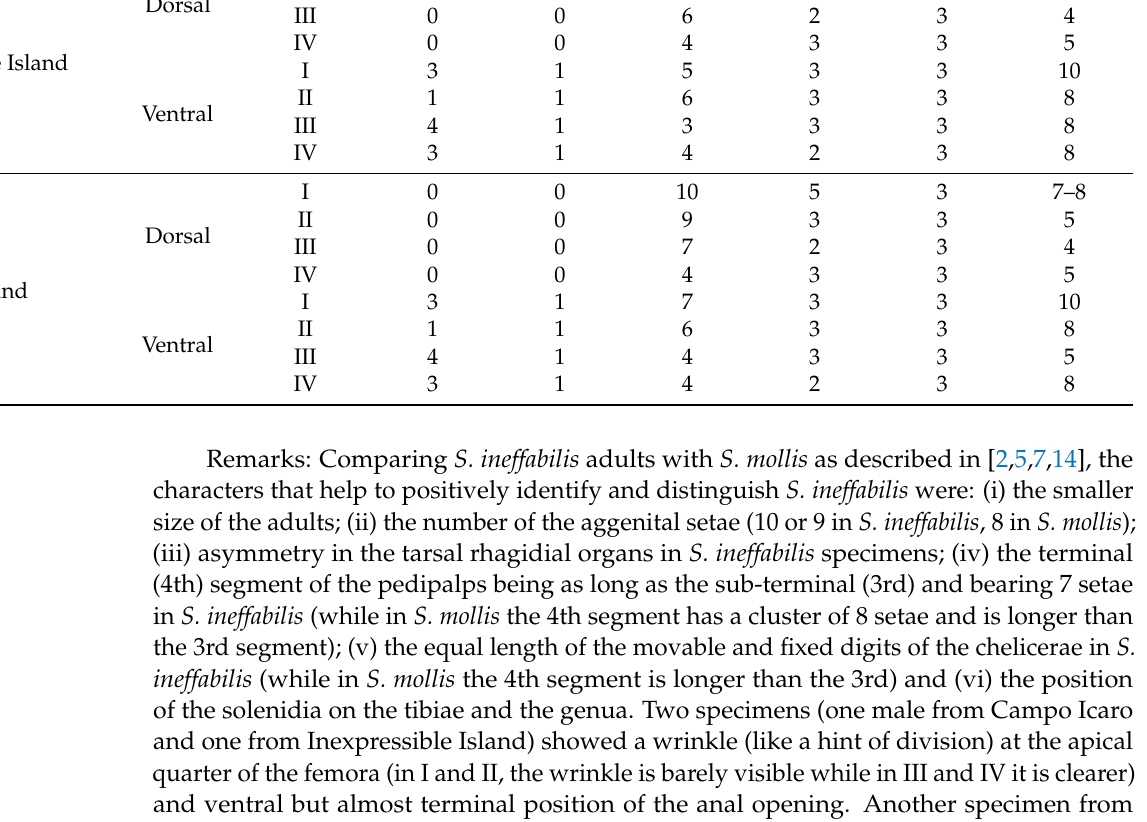
Inexpressible Island